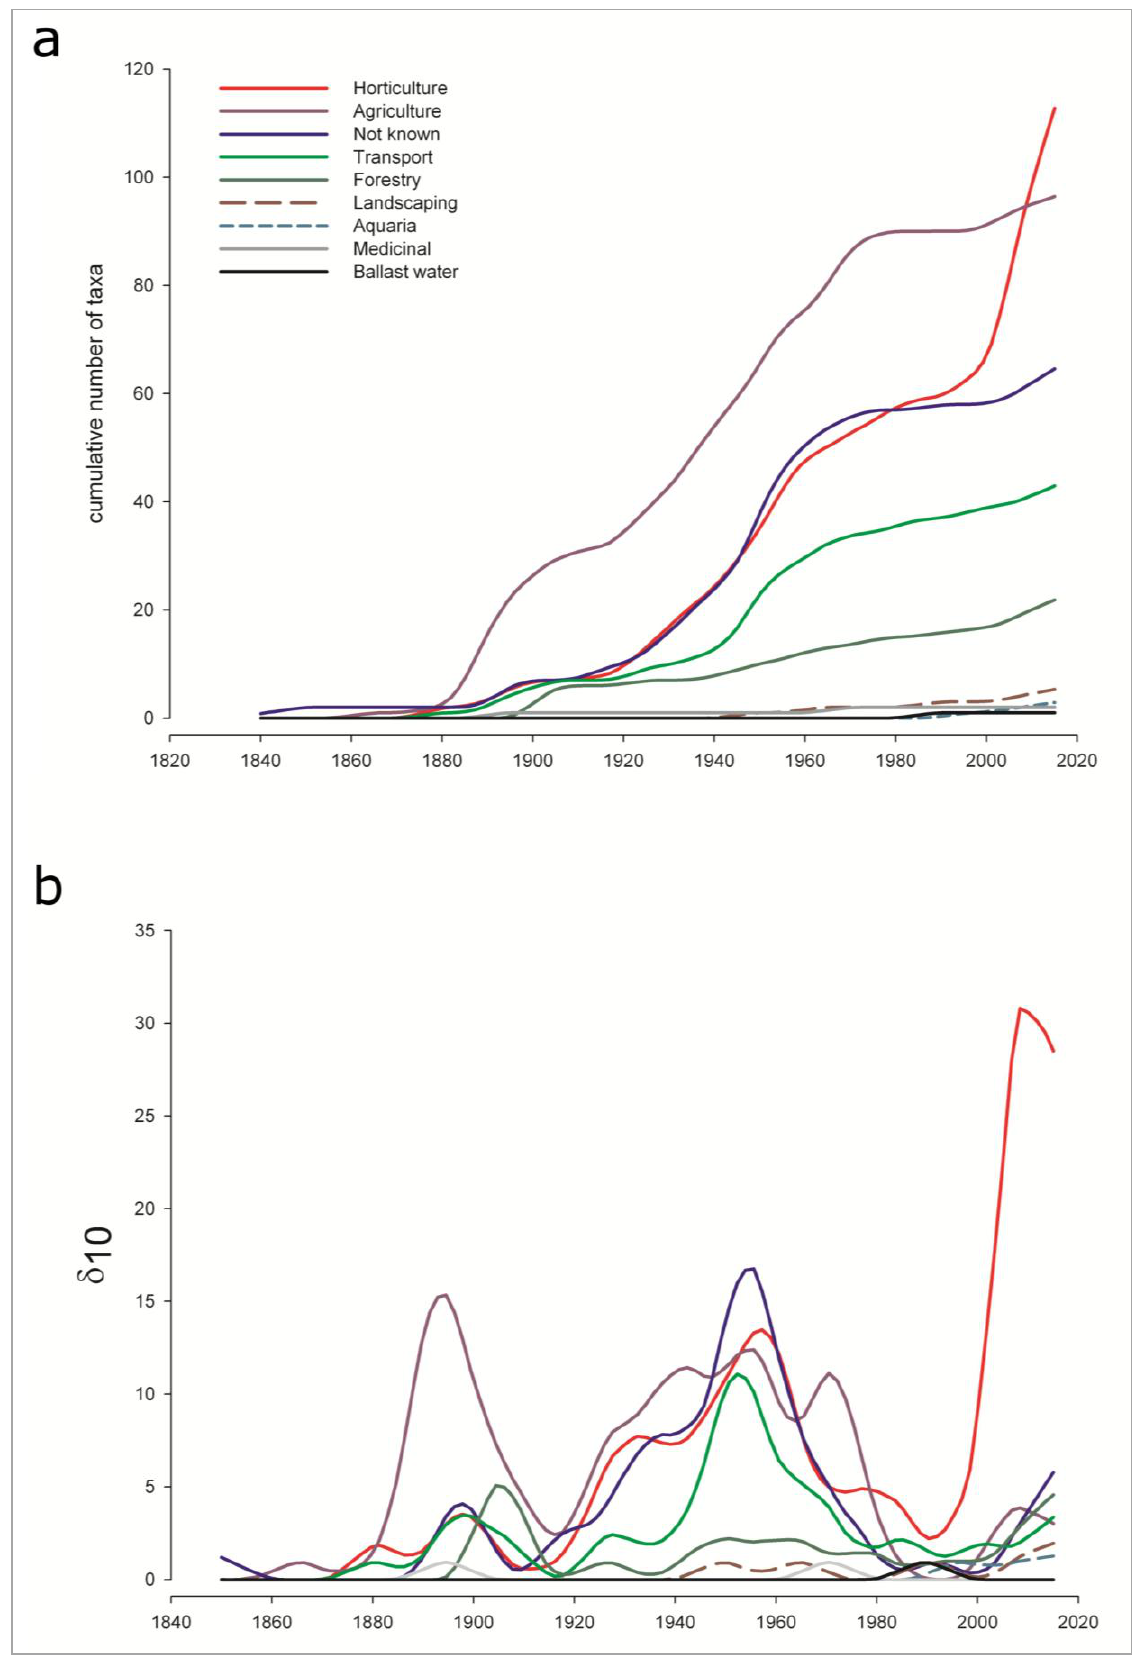
Fig. 1. LOESS curves showing temporal development of pathway use (a) and activity of each pathway quantified using δ 10 index (b). Cumulative number of taxa was calculated on the basis of the number of per annum new taxa records for each